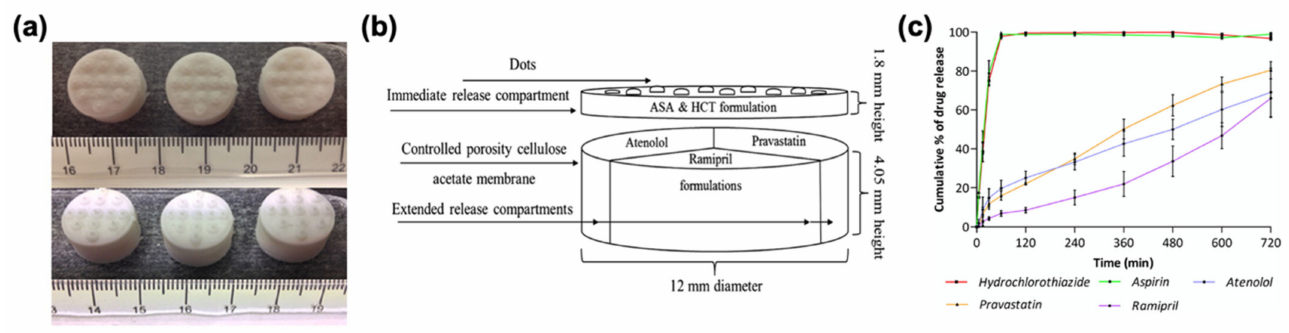
Figure 4. ( a ) DIW-printed tablets with multiple APIs (atenolol, pravastatin, ramipril, aspirin, and hydrochlorothiazide); ( b ) diagram of the tablet design with immediate and extended release compartments; ( c ) drug release profile of each drug from the tablet. Adapted with permission from Reference [138]. Copyright 2015,